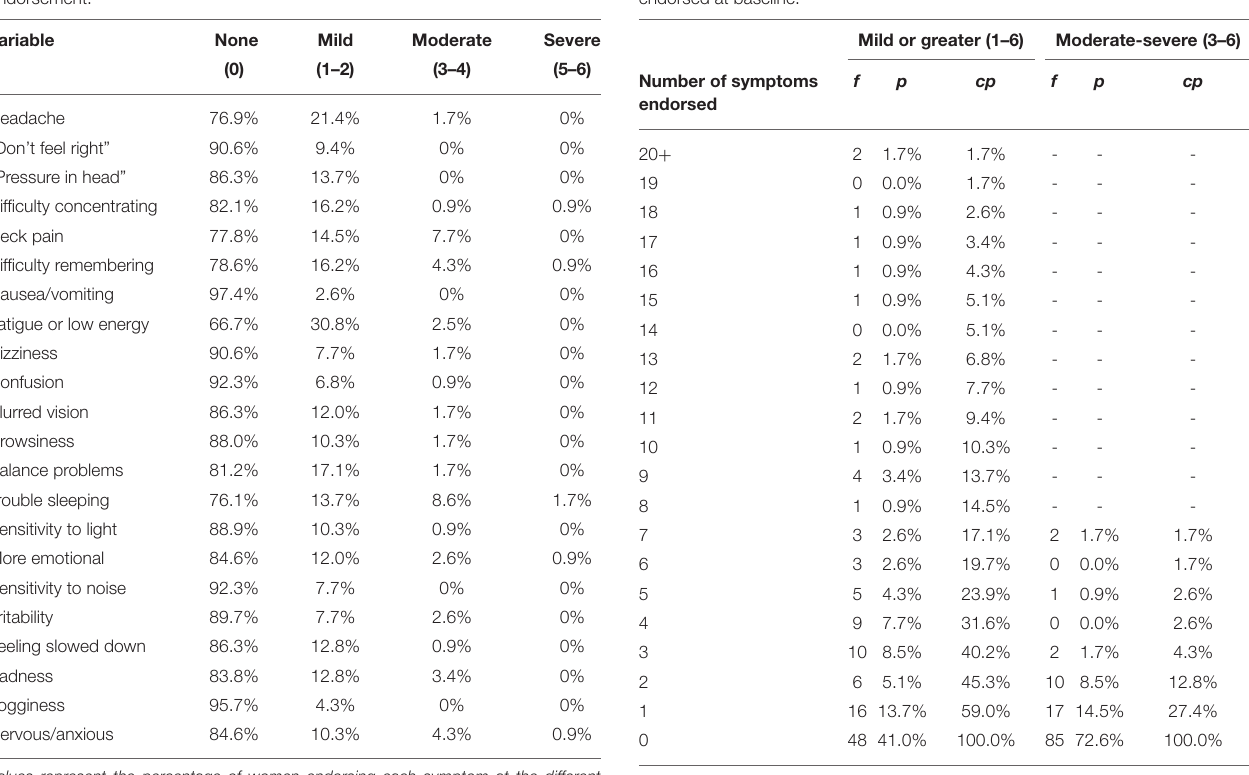
TABLE 5 | Cumulative frequency distribution of the number of symptoms endorsed at